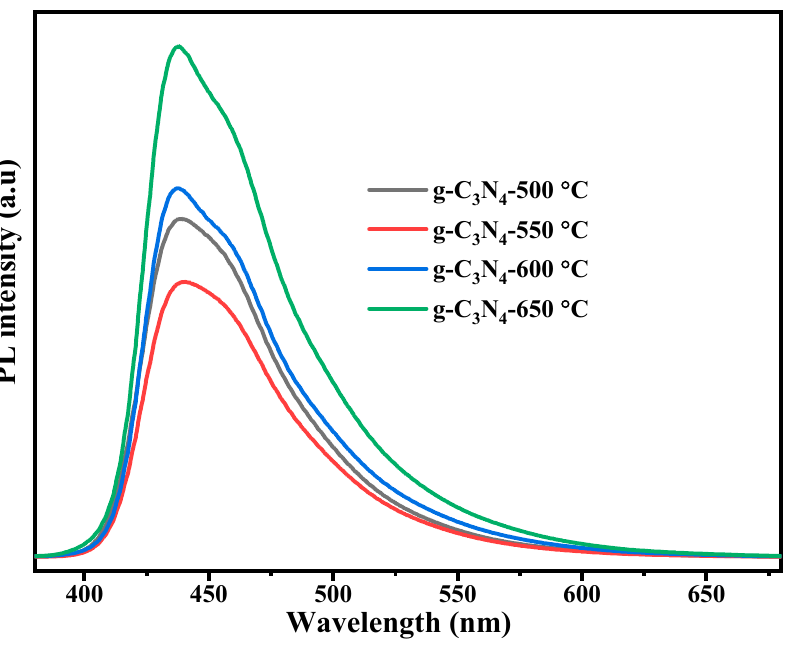
Figure 2. Photoluminescence spectra of g-C 3 N 4 samples prepared at different calcination tempera-